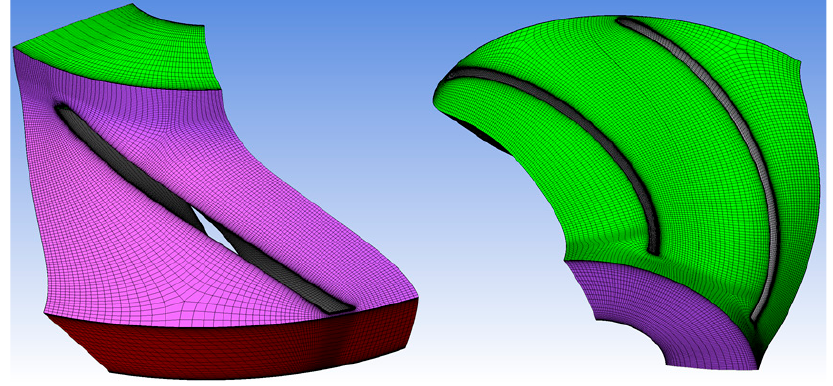
Figure 2. Grid details of the impeller and diffuser.